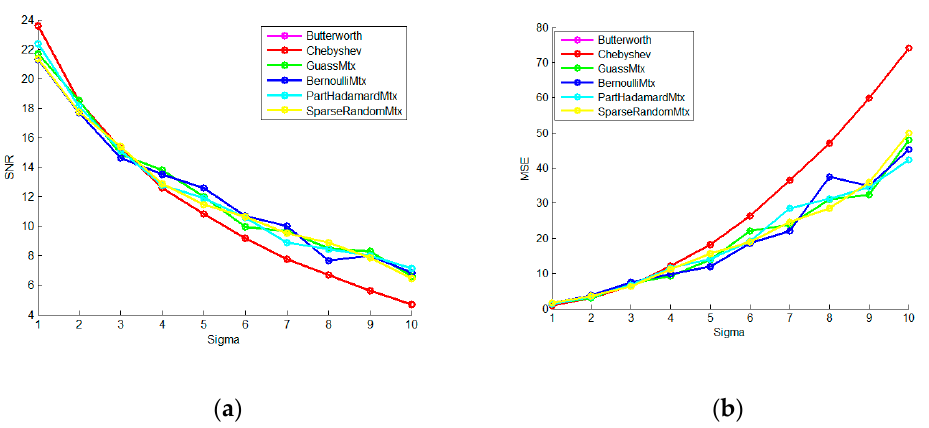
Figure 11. The Experiment on Intensity Change of Noise ( a ) is the SNR curve of FIR filtering and BPDN compressive sensing denoising methods based on five sampling matrices when sigma changes from 1 to 10, and ( b ) is the MSE curve of the denoising methods when sigma changes from 1 to